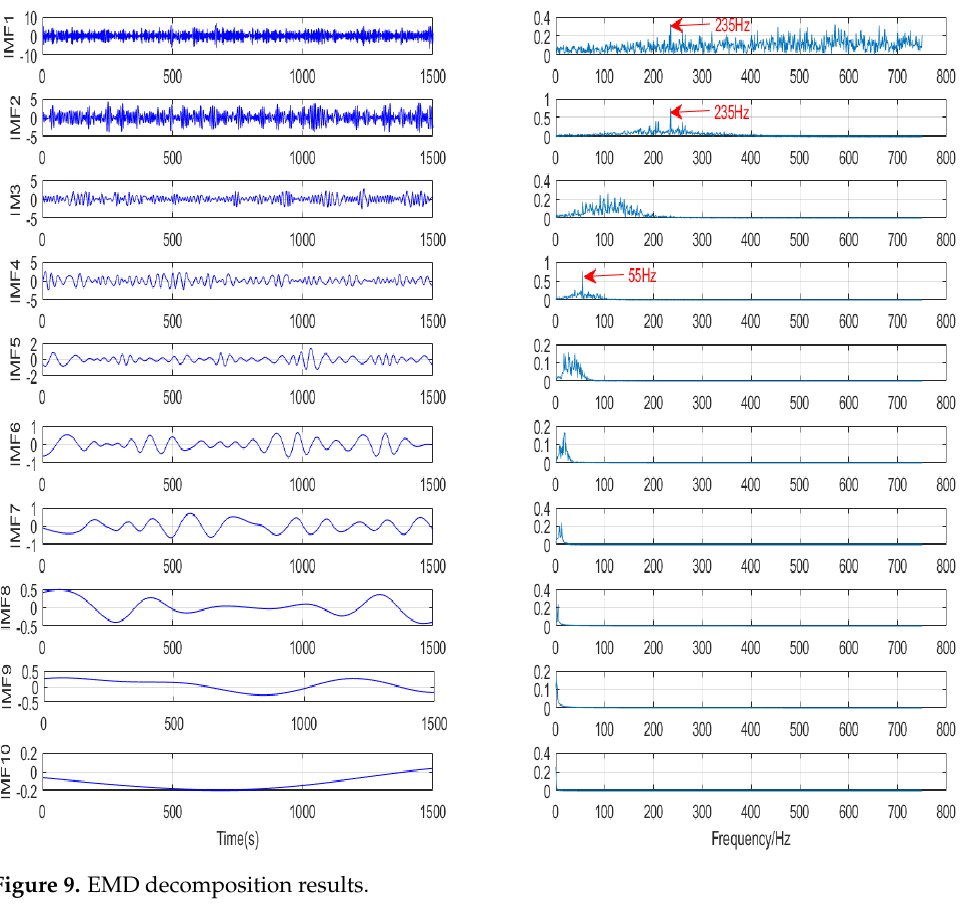
Figure 9. EMD decomposition results.